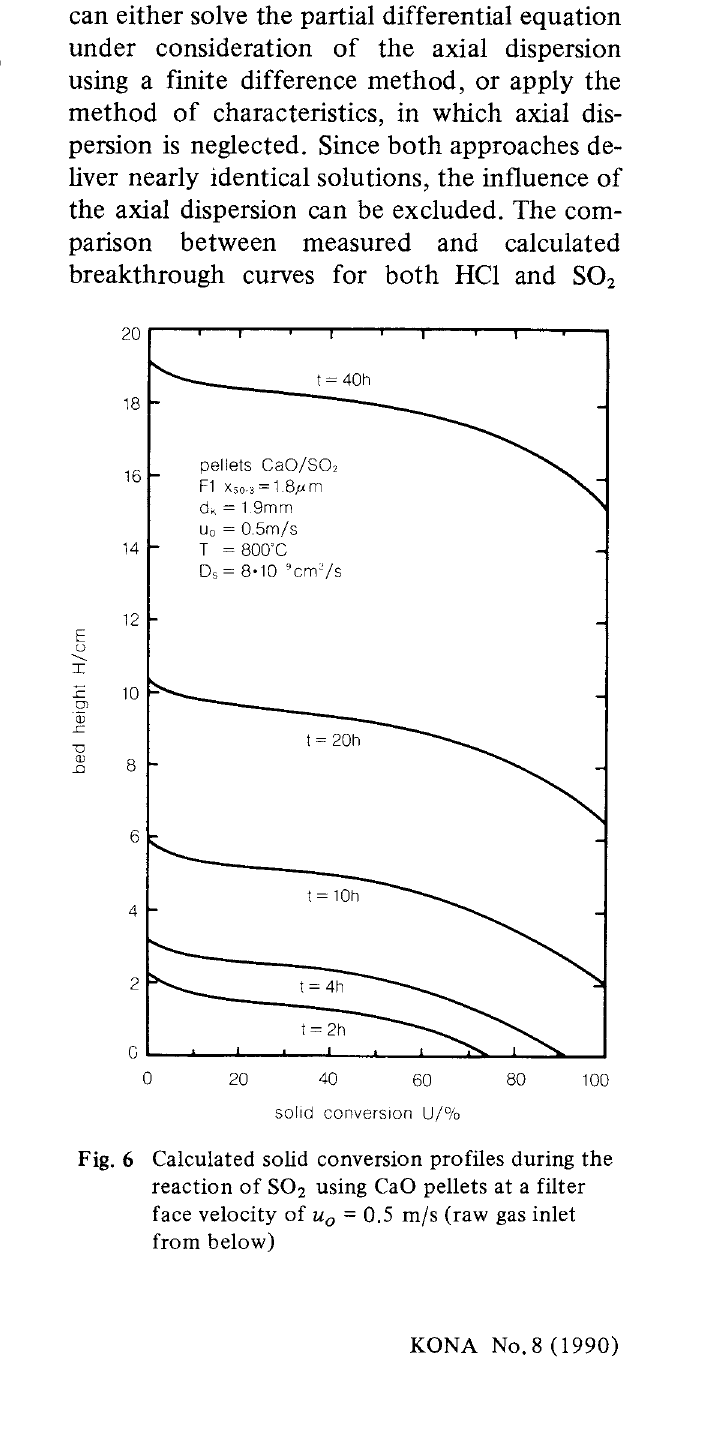
Calculated solid conversion profiles during the reaction of S0 2 using CaO pellets at a filter face velocity of u = 0.5 m/s (raw gas inlet 0 from